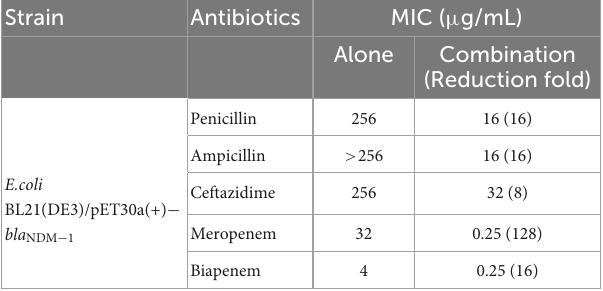
Alone Combination (Reduction